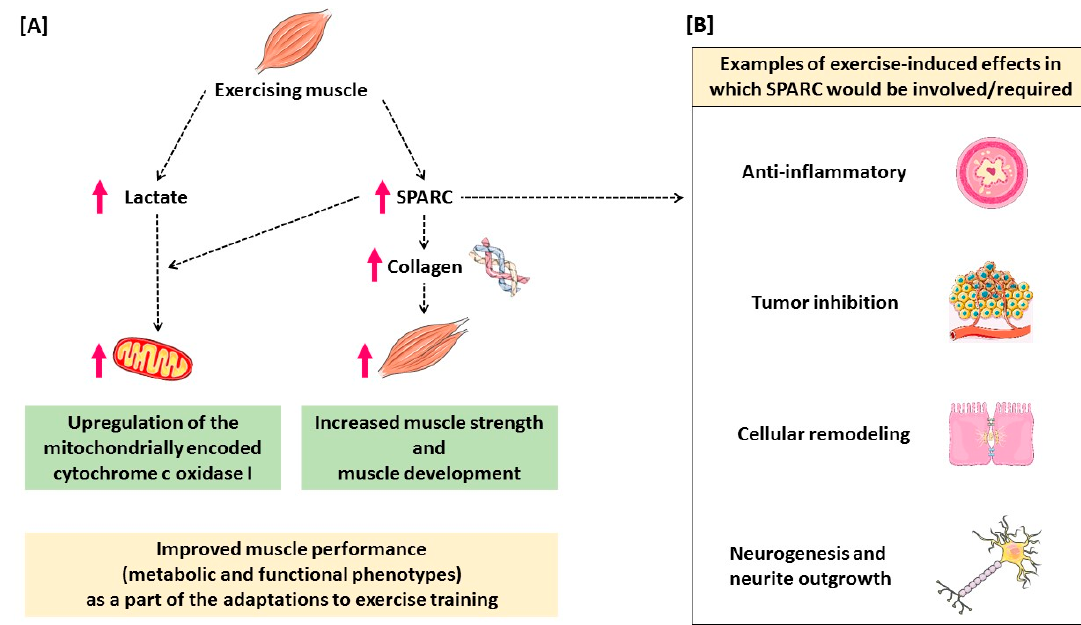
Figure 3. Hypothetical mechanisms linking SPARC to the exercise-induced SPARC-mediated changes in the skeletal muscle phenotype. [ A ] Exercise induces the secretion and expression of SPARC as well as the production of lactate. Our data suggest that, whereas SPARC enhances collagen expression and muscle strength, the lactate increases mitochondrial enzyme expression in a SPARC-dependant manner (probably via mitochondrial biogenesis induction) and, therefore, the oxidative phosphorylation capacity. [ B ] The similarities between exercise benefits and effects shown to be regulated or modulated by SPARC, such as inflammation, cancer growth, metabolic and structural remodeling of the skeletal muscle, and even neurite outgrowth and neurogenesis, all suggest that part of exercise benefits would be mediated by or dependent on SPARC expression. Abbreviation: SPARC, secreted protein acidic and rich in